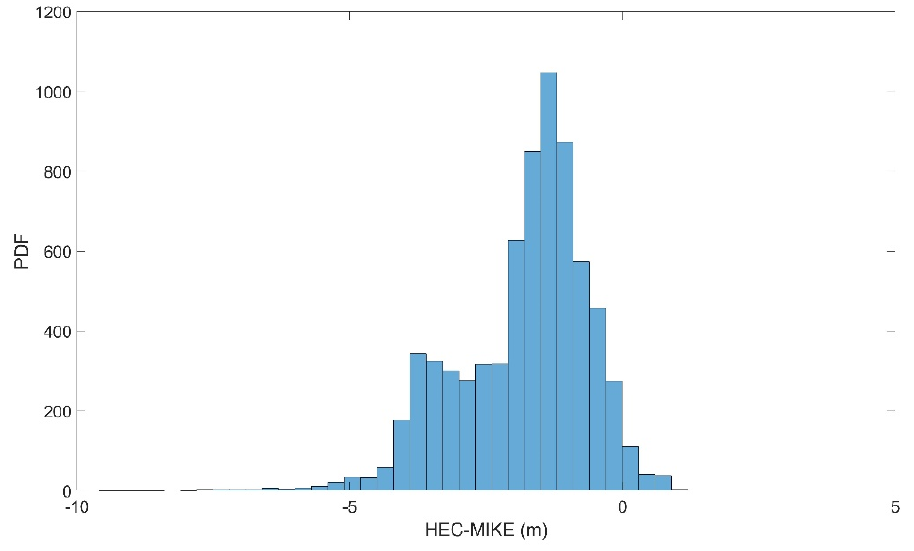
Figure 16. Distribution of the residuals HEC minus MIKE.